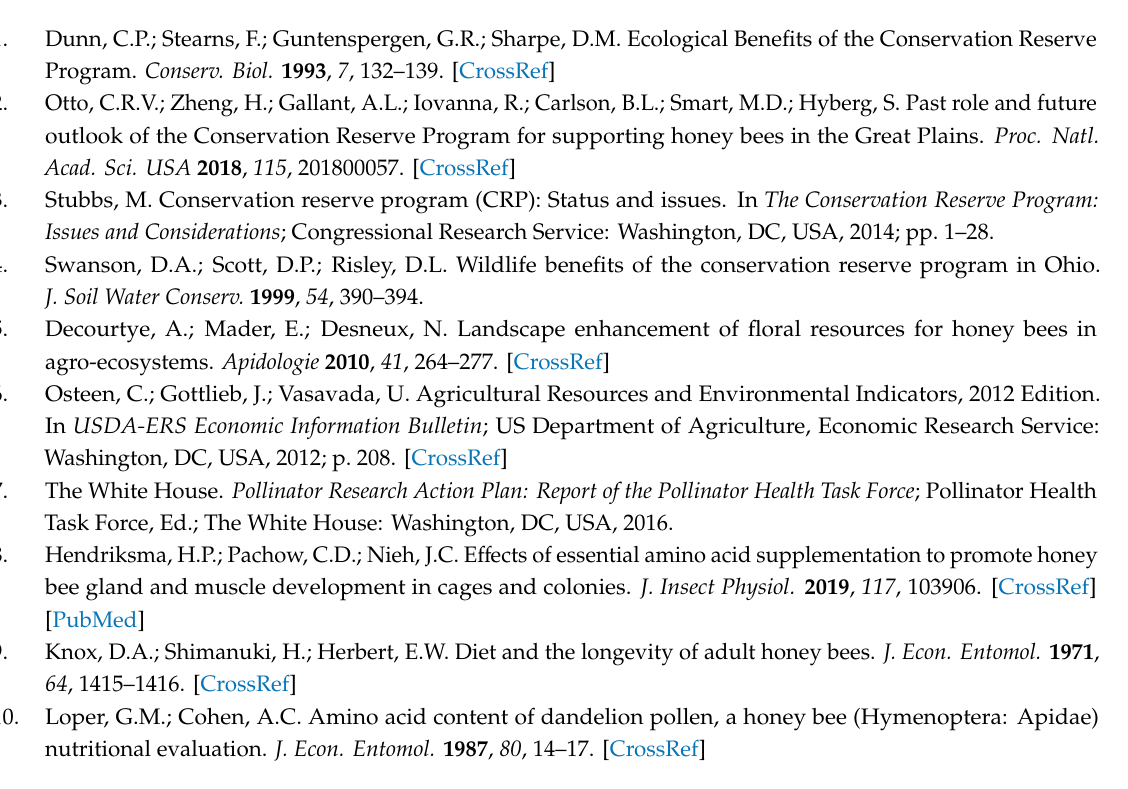
Table S1: Primer sequences for PCR amplification of pollen samples, Table S2: Diversity statistics for pollen metabarcoding samples, Table S3: Proportional abundance of taxa detected in pollen samples in 2016, Table S4; Proportional abundance of taxa detected in pollen samples in